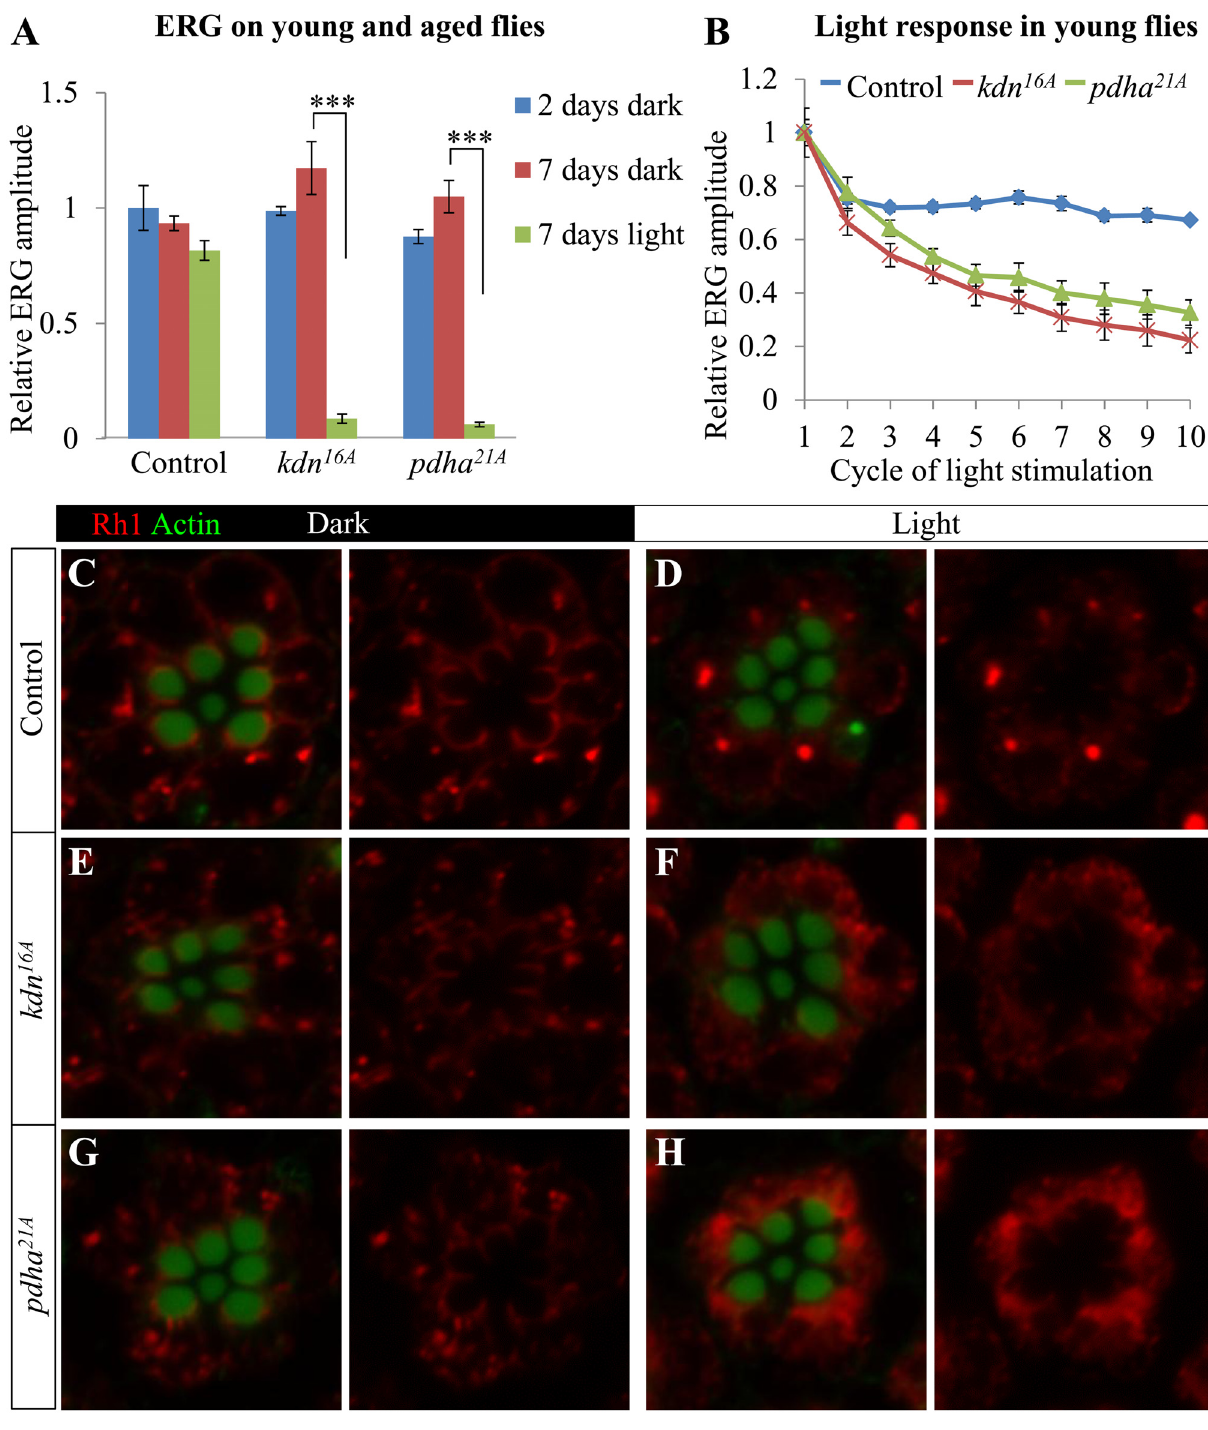
Fig 9. Light-induced degeneration due to loss of CS and Pyruvate dehydrogenase. (A) Quantification of relative ERG amplitudes from control, kdn 16A , and pdha 21A eye clones. Flies were reared in the dark for two (blue) or seven days (red) or in constant light for seven days (green). (B) Quantification of relative ERG amplitudes measured during repetitive light stimuli (1 sec light and 1.5 sec dark, as shown in Fig 3A) from control, kdn 16A , and pdha 21A eye clones. Error bars represent ± SEM; Student's t test ( p -value: *** < 0.001). (C – H) Whole mount Rh1 (red) immunostaining in control, kdn 16A , and pdha 21A mutant PRs. Rhabdomeres are marked by Phalloidin and Actin (green). The flies used in this experiment were 2 – 3 d old and reared in the dark (C, E, G) or exposed to ~24 h of light (D, F,